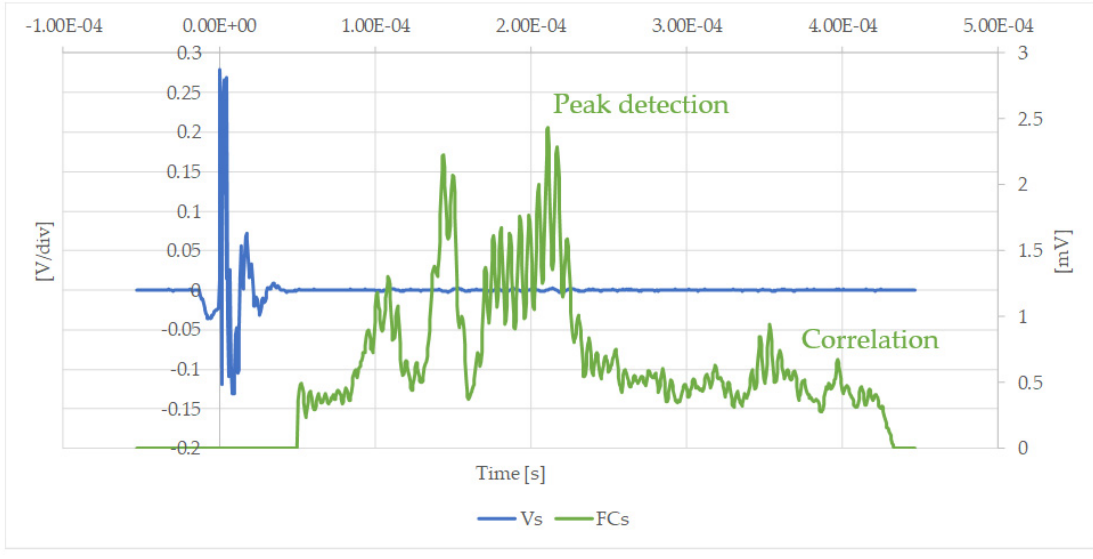
Figure 24. New sensor results: Experimental signal in the receiver, Vs [V], and filtered signal, FCs [mV] after using the correlation filter with a partial silicone blockage in position B-4.